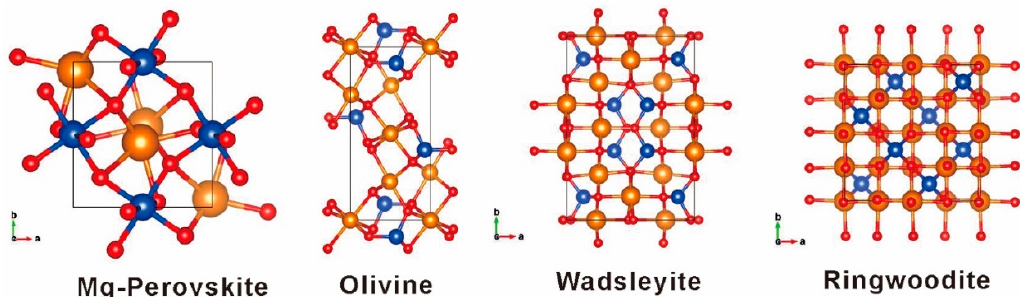
Figure 2. Crystal structures of perovskite (Mg VI SiO 3 ), olivine (Mg 2IV SiO 4 ), wadsleyite (Mg 2IV SiO 4 ), and ringwoodite (Mg 2IV SiO 4 ). Magnesium, oxygen, and silicon atoms are represented by orange, red, and blue color individually.